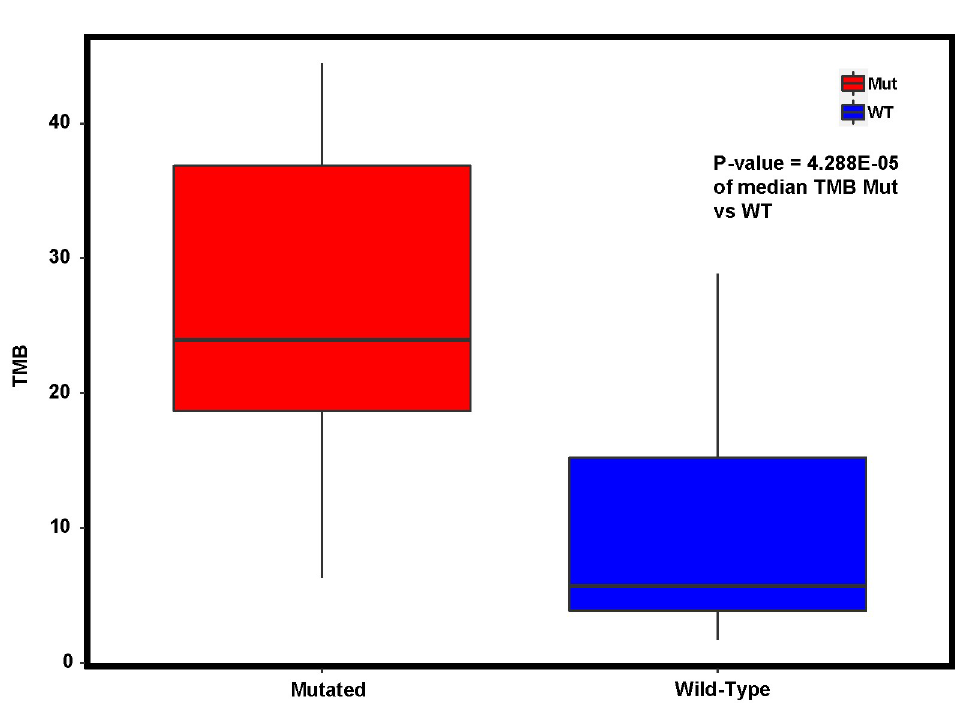
Fig 7. Tumor mutation burden in DACH1 mutated patients compared to DACH1 wild-type as a continuous variable. The median is statistically different between the two (p-value = 4.288 E-05). TMB high is defined as � 20 mutations per